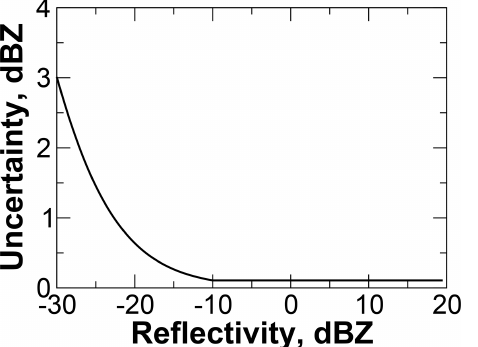
Figure 4. Actual rms errors and the fitted model for uncertainty due to the assumed exponential size distribution.